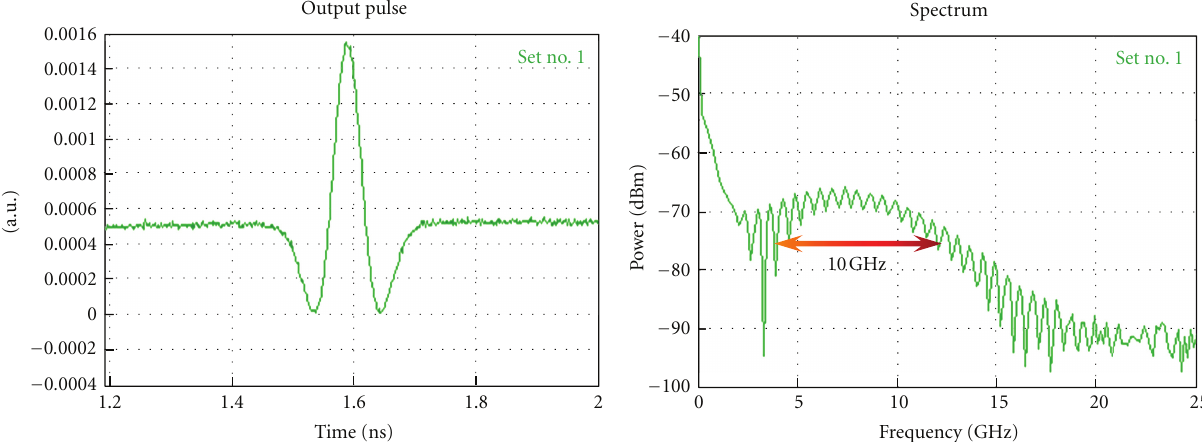
Figure 6: The generated doublet (a) and its spectrum (b).